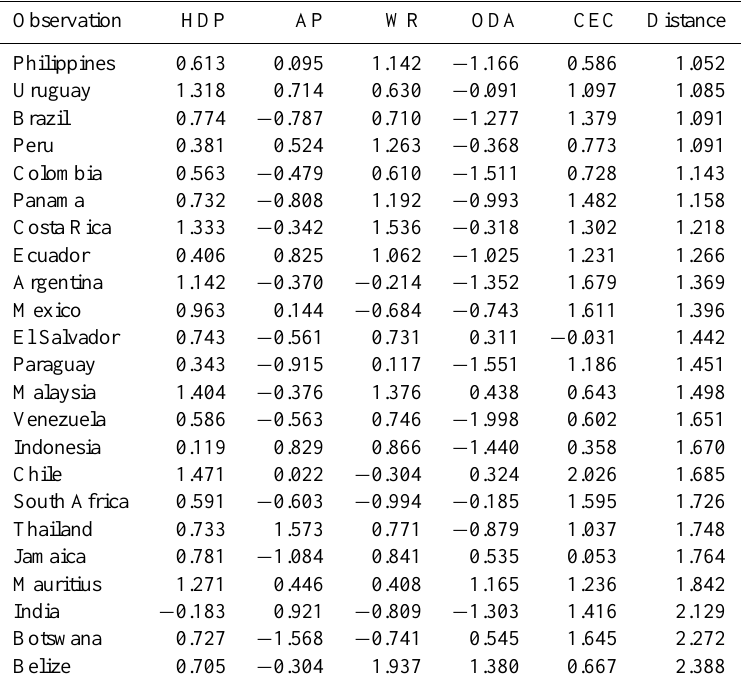
Table 7. Factors loadings and distances to the centroid of the profile 1: the last 7 countries of the list are considered outliers with divergence behavior from the average value.